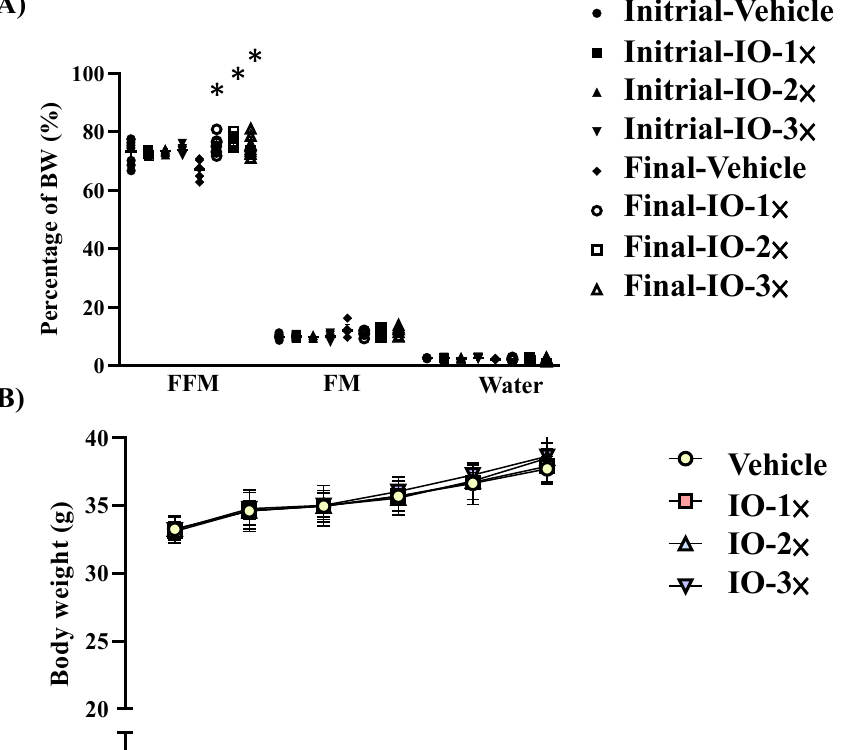
Figure 1. Body composition of the mice with Inonotus obliquus (IO) supplementation ( A ); body composition has two points of detection. The initial test was conducted before IO supplementation, and the final test was conducted 6 wk after IO supplementation ( B ). Increased body weight in IO- treated mice. Male Institute of Cancer Research (ICR) mice were supplemented with the vehicle, IO-1 × , IO-2 × , and IO-3 × for 6 wk. Values are the mean ± standard deviation (SD) for n = 8 mice per group. * p < 0.05 compared with the vehicle